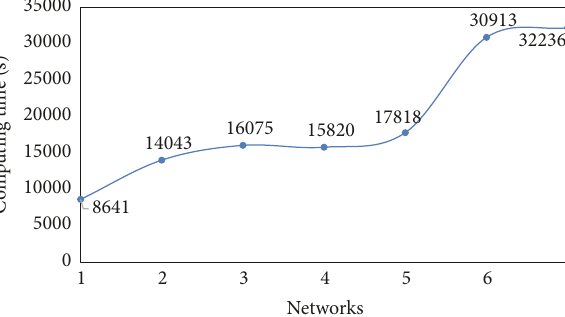
Figure 9: Computing time with increasing scale of